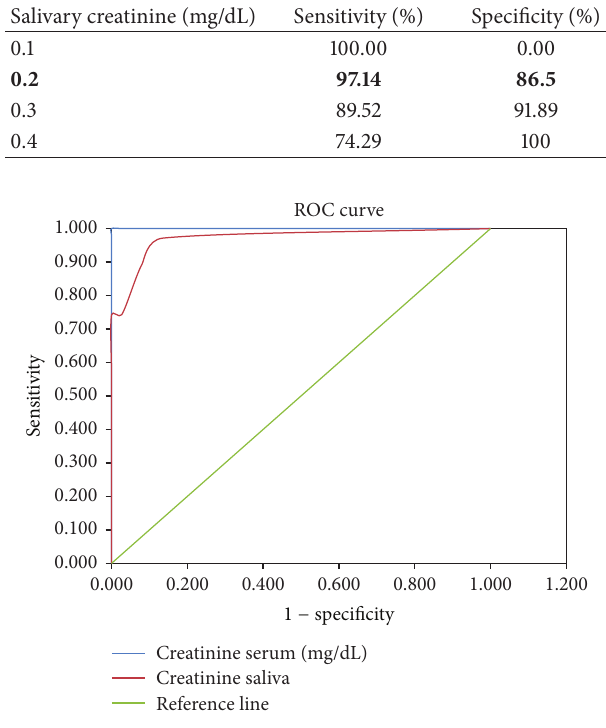
Figure3:Receiveroperatingcurveforserumandsalivarycreatinine